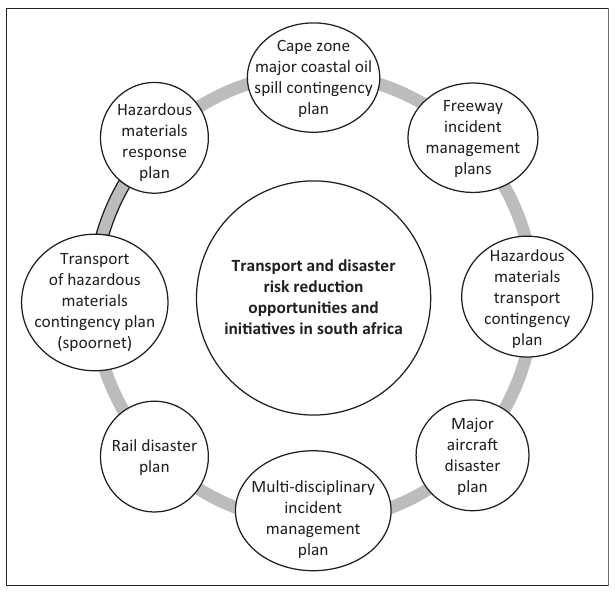
FIG URE 3: Transport and disaster risk reduction opportunities and initiatives in South